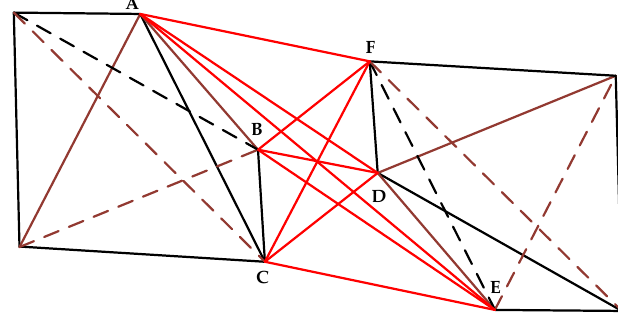
Figure 2. The morphing wing coordinate system diagram.